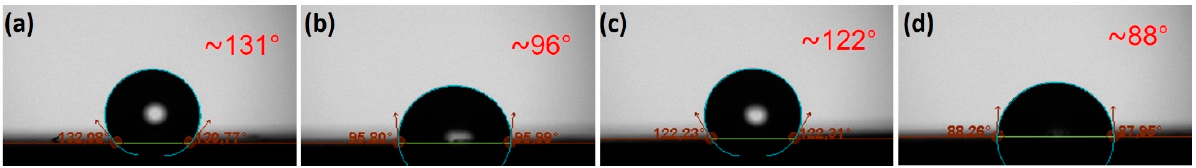
Figure 8. Contact angles of the coated surfaces ( a ) free – GNS and reinforced with ( b ) 0.5, ( c ) 1.0, and ( d ) 1.5 wt% GNS.